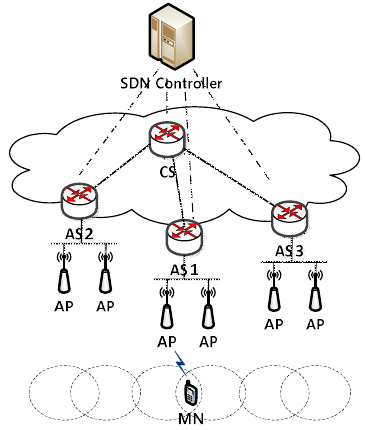
Figure 1. Access network architecture of software-defined networking (SDN)-based mobile networks.